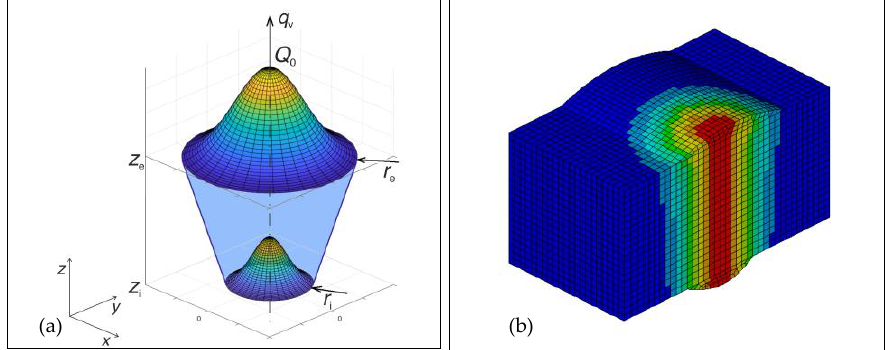
Figure 6. 3D conical heat source model: ( a ) scheme and ( b ) an example of its application to the FE model.